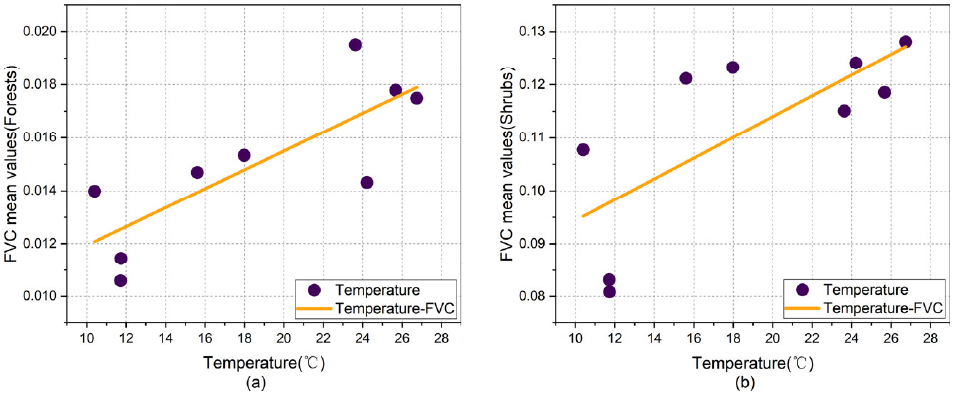
Figure 8. Temperature and vegetation regeneration relationship map: ( a ) forests-temperature and ( b )